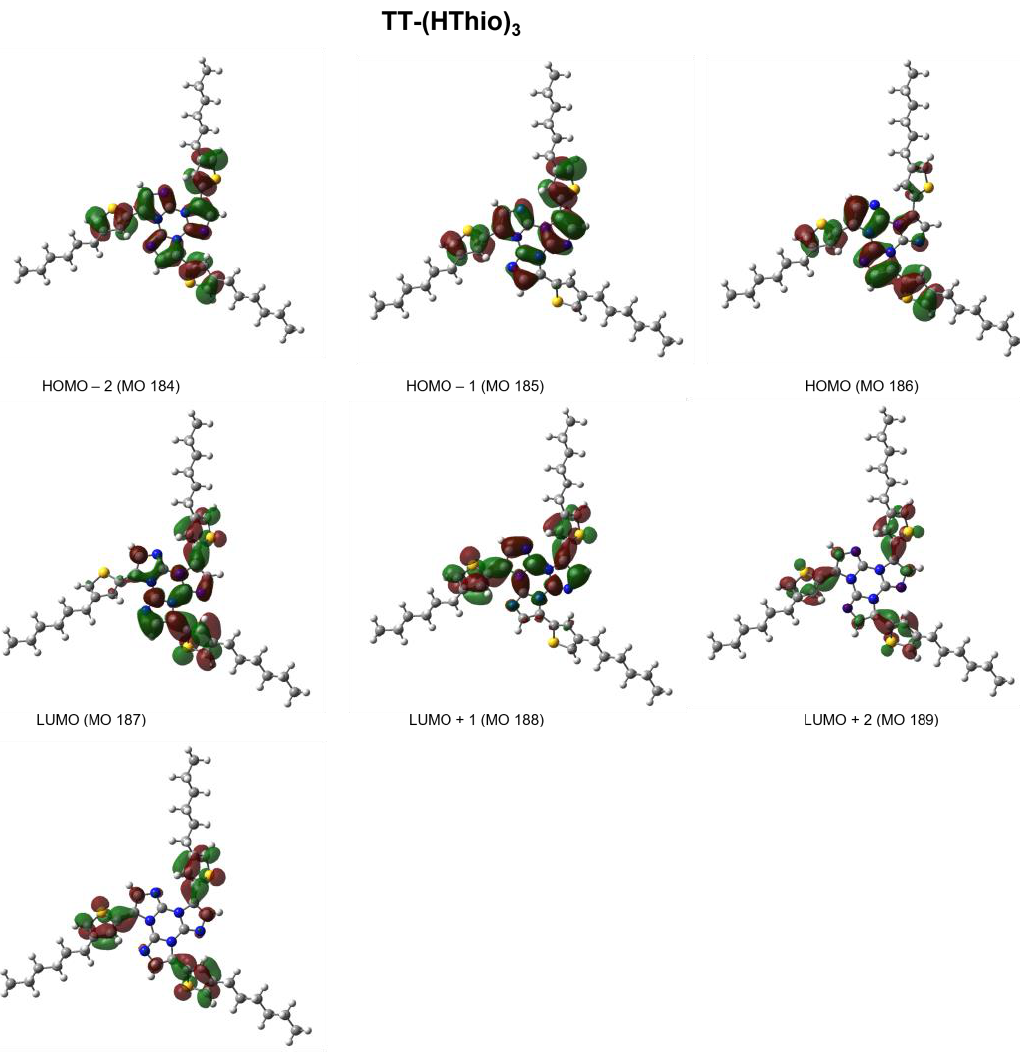
Figure 9. Plots of the ω B97X/6-311++G(d,p) MOs mainly involved in the lowest energy transitions of TT-(HThio) 3 (isosurfaces value 0.02).